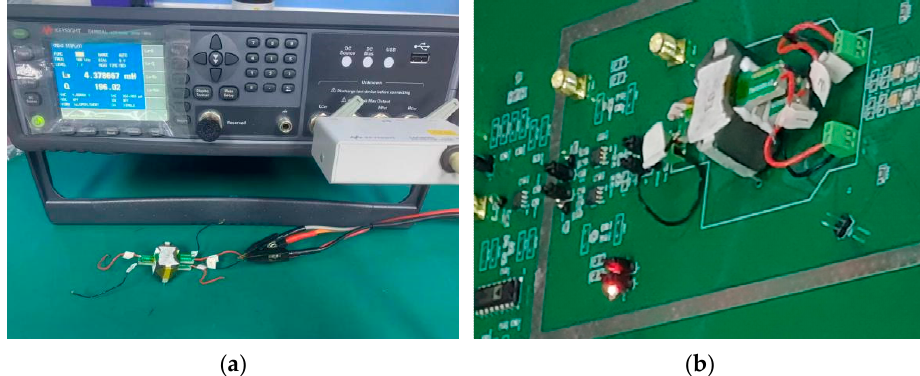
Figure 10. ( a ) LCR meter used to measure the parameters of the self ‐ developed planar transformer;